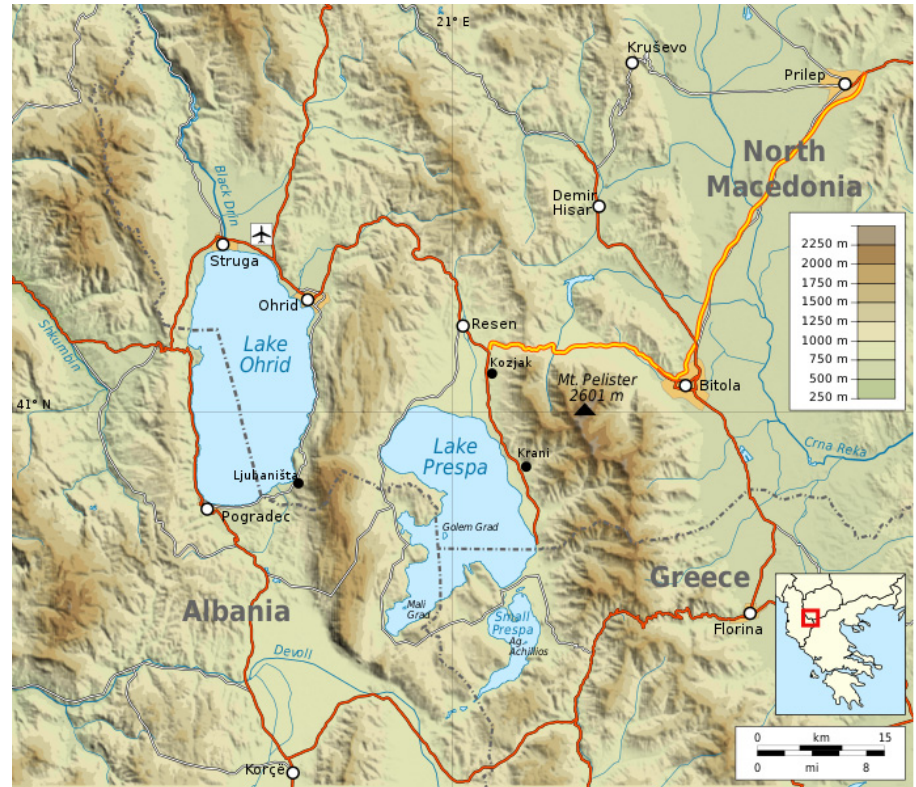
Figure 1. Topographic map of the Ohrid and Prespa lakes (from Wikimedia Commons).